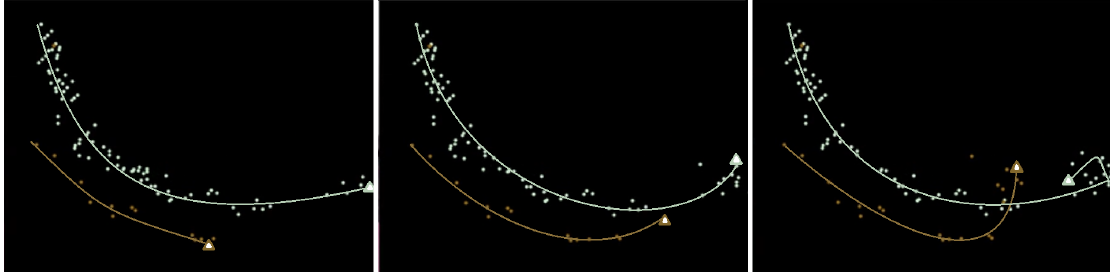
Figure 5. Tracks (drawn by a human) for two people being estimated over time (approx. ten seconds apart). Full circles indicate the measured points from the images, and the triangles at the end of each track indicate the next Kalman Filter estimated position, which is treated as the prediction for that identity